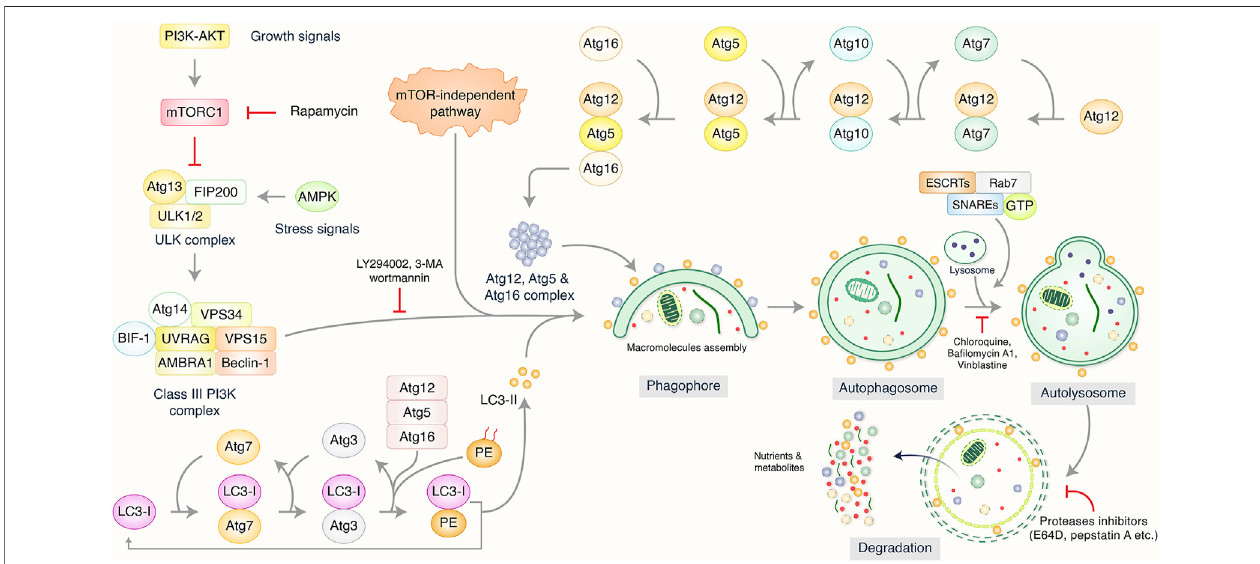
FIGURE 2 | Biological function and molecular mechanism of autophagy pathway. Autophagy has been initiated by the formation of pre-autophagosome structure viatheactionofseveralproteins.PI3K-AKTandmammaliantargetofrapamycin(mTOR)havebeenin fl uencedtoinitiatepre-autophagosomeassemblyviaassociationof ULK1/VPS34/Beclin-1 complex. Additionally, Atg5/Atg12/Atg16 and Atg12/Atg5/LC3 complexes are involved to create phagophore nucleation and macromolecules accumulation which has been elongated as well as bind to autophagosome formation. Lysosome binds mature autophagosome by the help of ESCRT/SNARE/ Rab7 protein complex, resulting in autolysosome formation. Finally, autolysosomes have been abolished by acid hydrolases resulting in the release of recycling metabolites as well as nutrients.